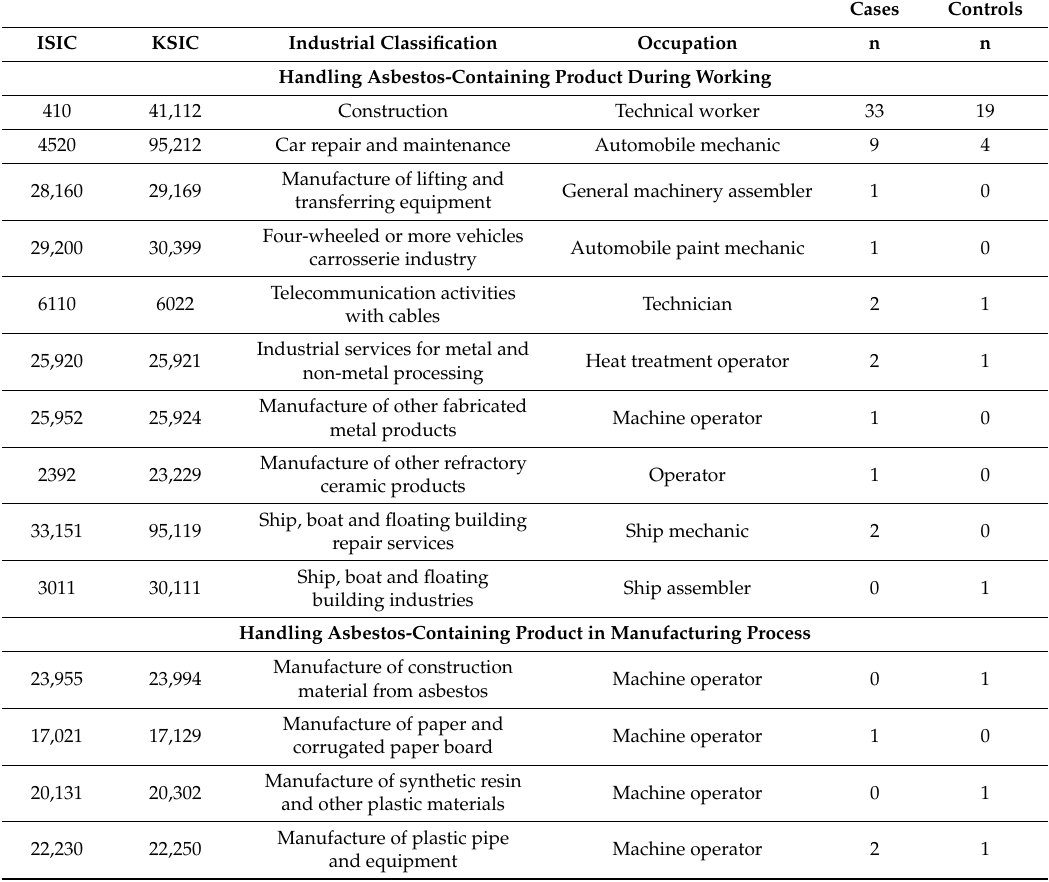
Table 2. Distribution of occupations with exposure to asbestos based on Indonesian Standard Industrial Classification (ISIC) 2015 and Korean Standard Industrial Classification (KSIC) Rev 9.